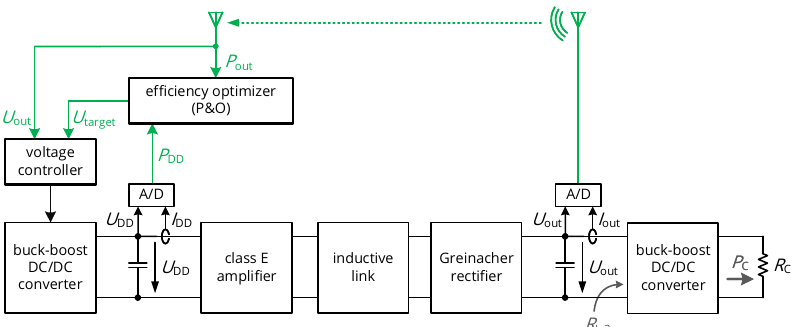
Figure 6. Circuit topology for simultaneous power feedback and maximum efficiency point tracking: A digital primary-side controller regulates the rectifier’s output voltage to stabilize the wirelessly supplied system even in case of load and coil alignment transients. On top of this voltage controller for power feedback, a perturb-and-observe controller varies the setpoint on the voltage controller U target to tune the effective DC load resistance R L,2 and optimize the overall system efficiency. Efficiency data for the perturb-and-observe controller are acquired by the measurement of the DC power levels on primary and secondary